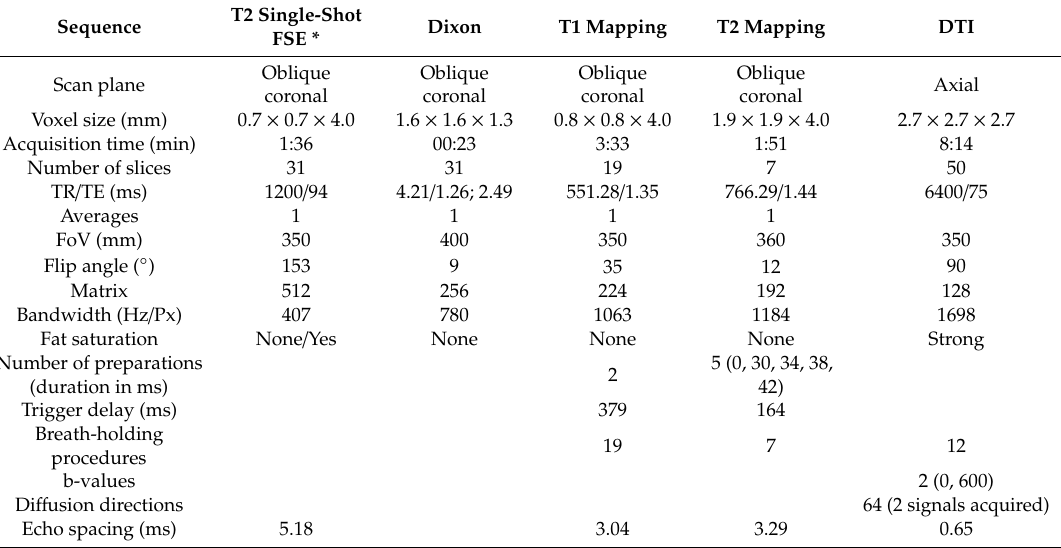
Table 1. Tabulated MR imaging